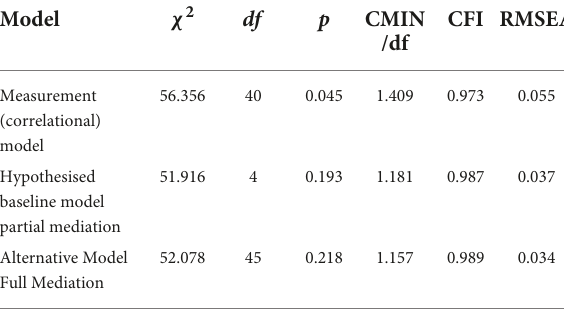
TABLE 2 Measurement model, hypothesised model, and alternative model